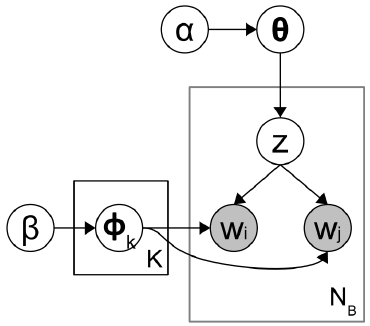
Figure 2. The graphical model of